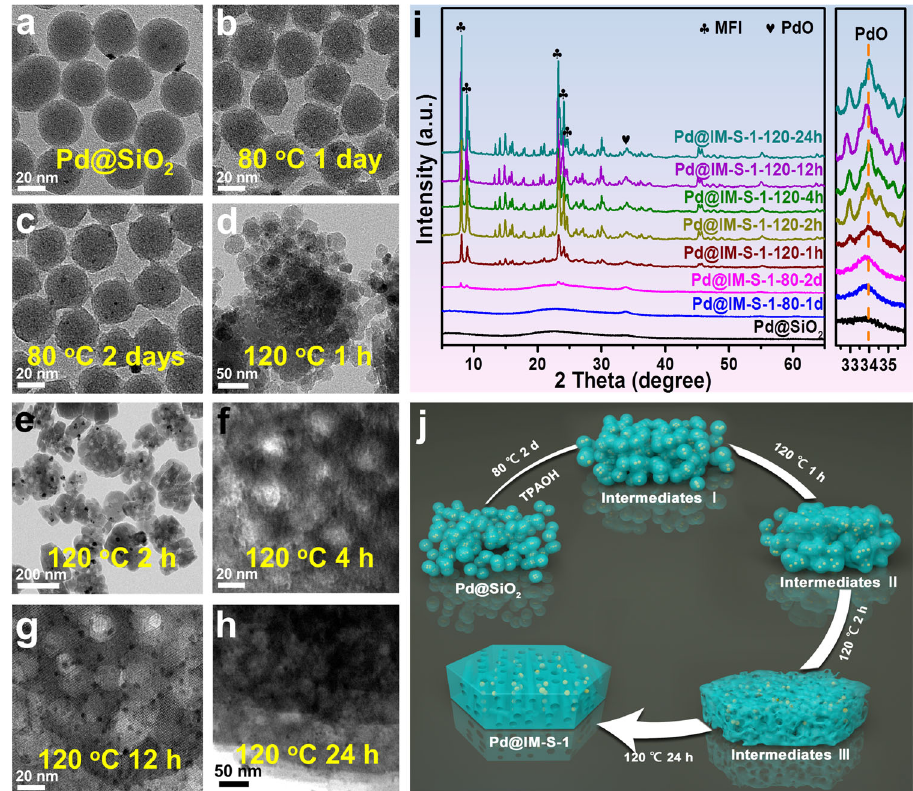
Fig. 3 Formation process of Pd@IM-S-1. a TEM image of Pd@SiO 2 , b , c TEM images of Pd@IM-S-1 crystallized 1 day and 2 days at 80 °C, respectively; d − h TEM images of Pd@IM-S-1 crystallized 1 h, 2 h, 4 h, 12 h, and 24 h at 120 °C, respectively; i XRD patterns of Pd@IM-S-1 crystallized between 80 and 120 °C at different crystallization time; j proposed formation process of intra-mesopore over